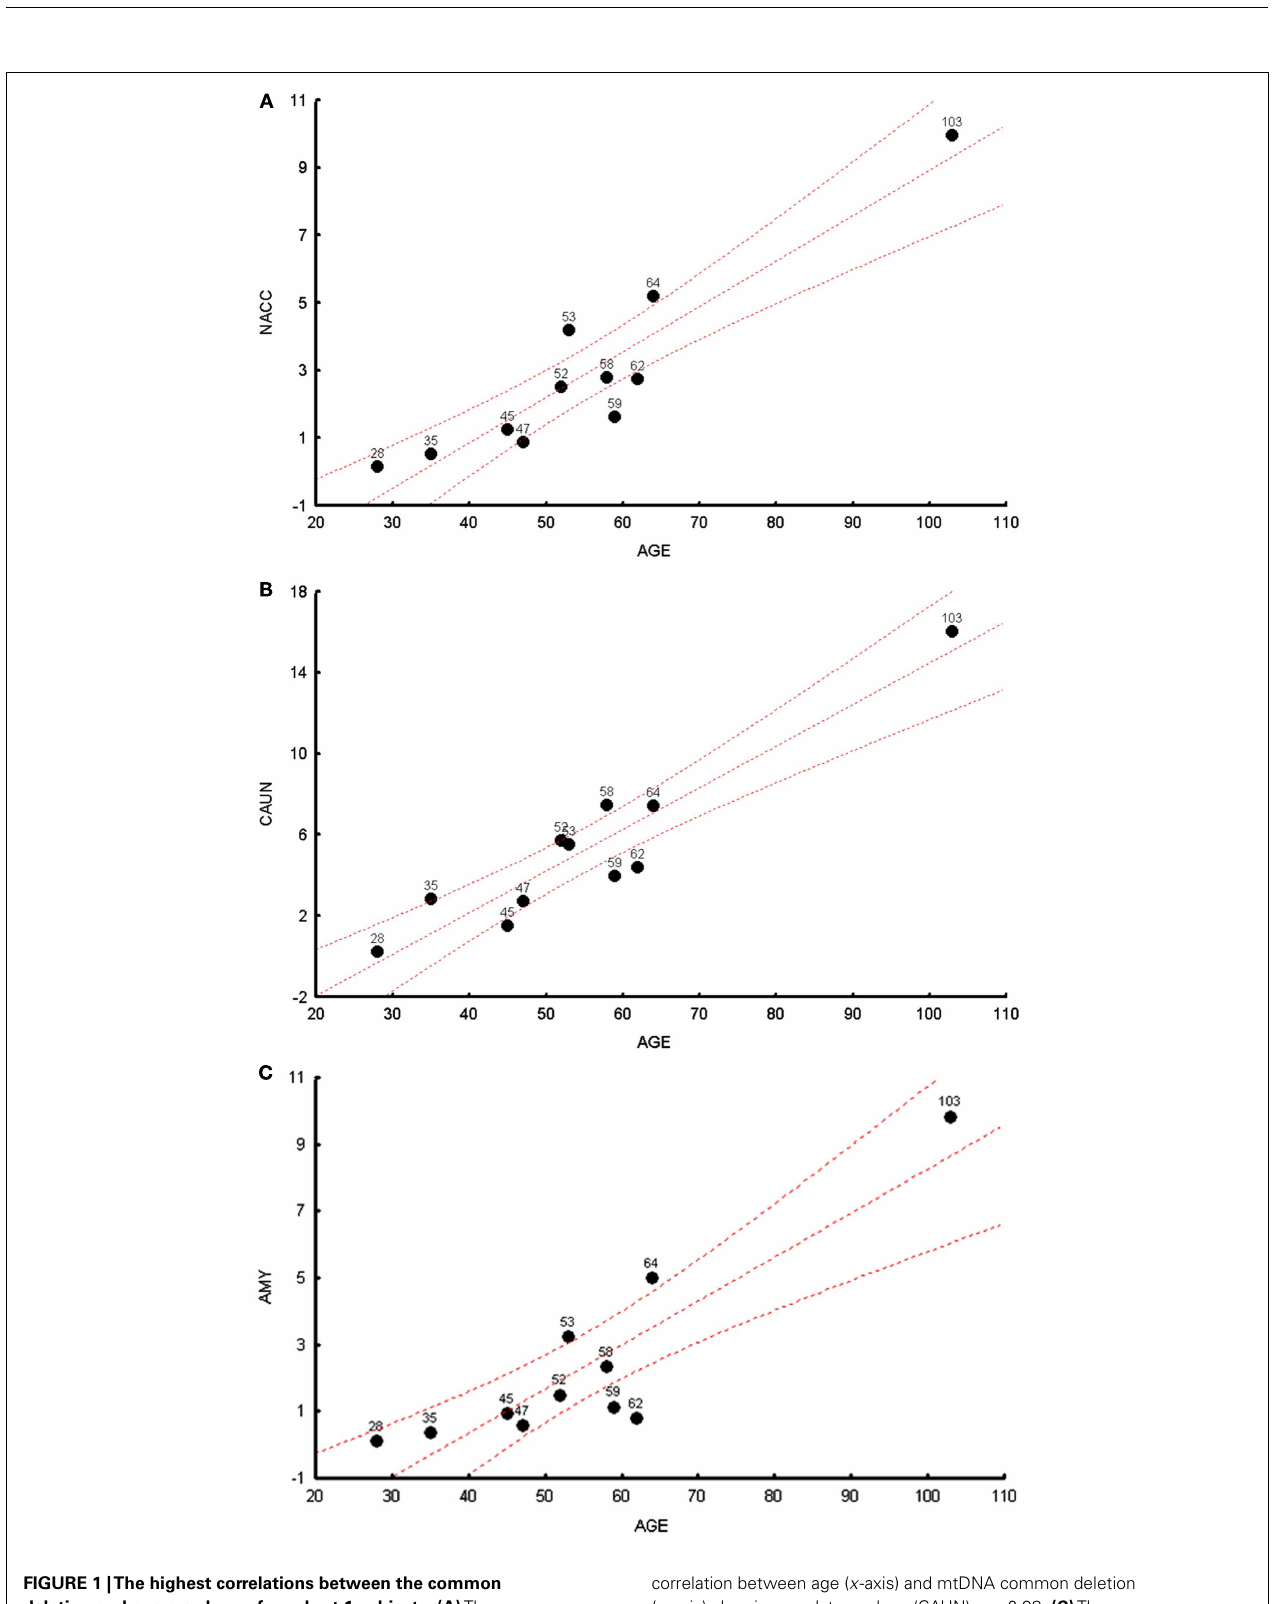
FIGURE 1 |The highest correlations between the common deletion and age are shown for cohort 1 subjects. (A) The correlation between age ( x -axis) and mtDNA common deletion ( y -axis) showing the nucleus accumbens (NACC), r = 0.97. (B) The